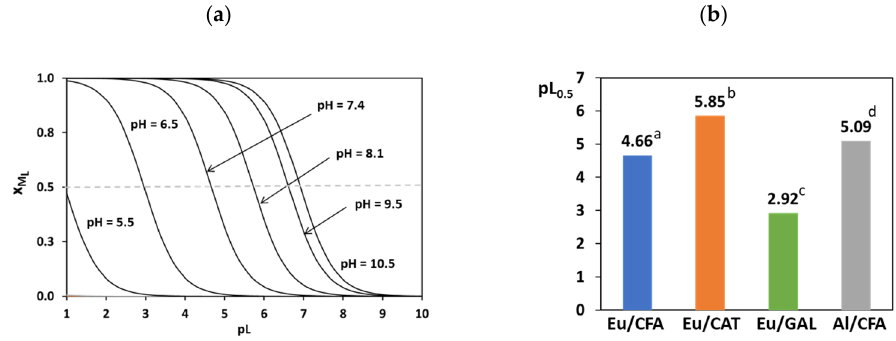
Figure 10. ( a ) Sequestration diagrams of Eu 3+ by CFA at different pH values, at I = 0.2 mol · dm − 3 in KCl (aq) , at T = 298.15 K. ( b ) pL 0.5 values calculated at pH = 7.4 for several M/polyphenolic systems (M = Eu 3+ , Al 3+ ) using data (a) determined in this work; reported in (b) [62]; (c) [63]; (d) [59].